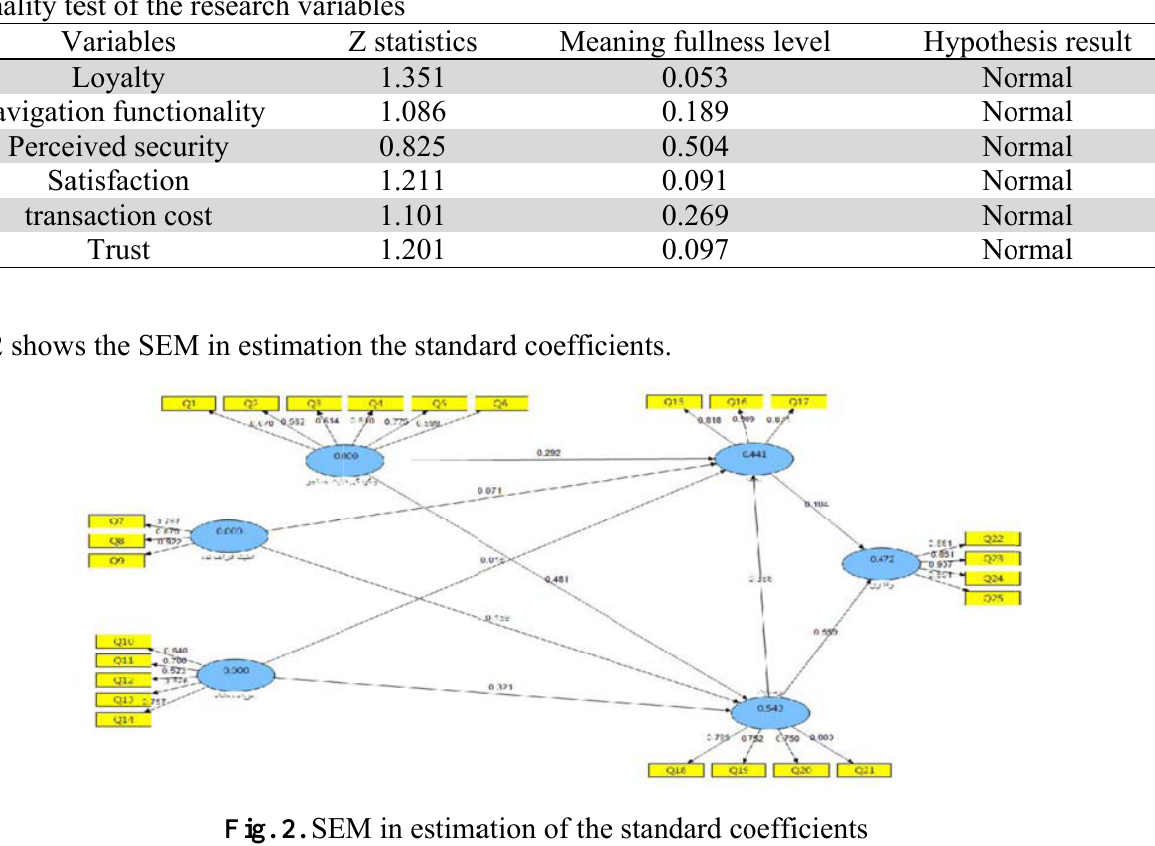
Indices of th Index Chi square/ de Goodness of fi Root Mean of Comparative f Normed fit ind Non-normed